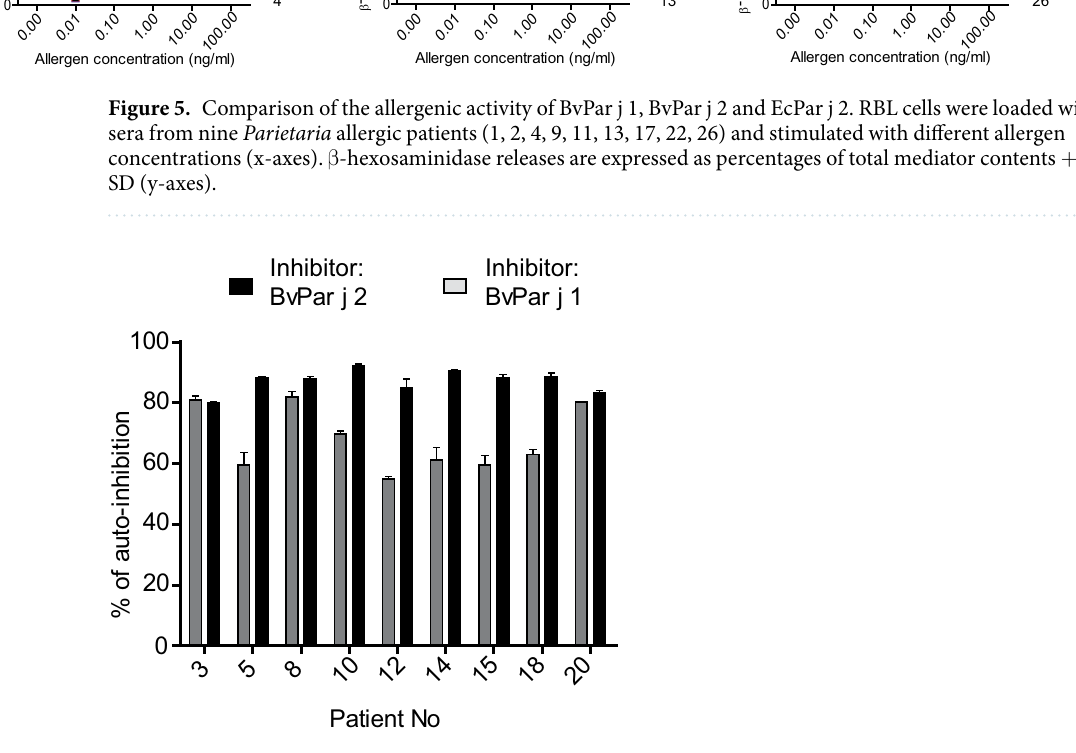
Recombinant Par j 1 and Par j 2 resemble the majority of allergenic IgE epitopes in Parietaria judaica pollen. The comparison of IgE levels specific for BvPar j 1, BvPar j 2 and Parietaria judaica extract indicates that BvPar j 2-specific IgE levels represent a higher proportion of IgE-specific for natural Parietaria